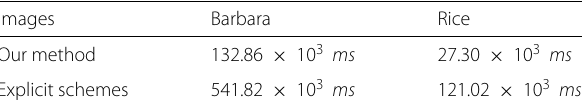
Table 2 CPU time of our algorithm and PMPL method for the Barbara and rice images